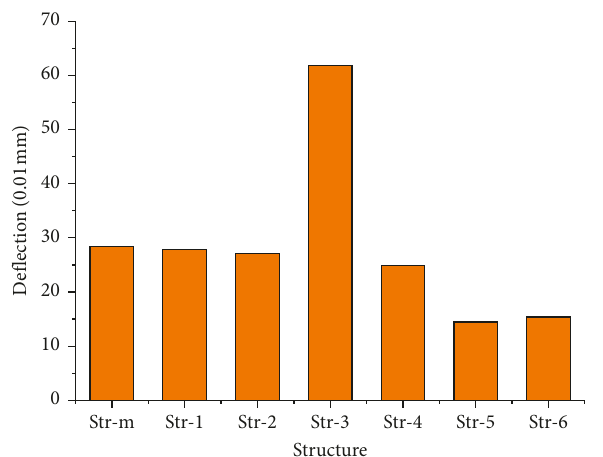
Figure 18: Compressive strains at the subgrade top surface of seven pavement